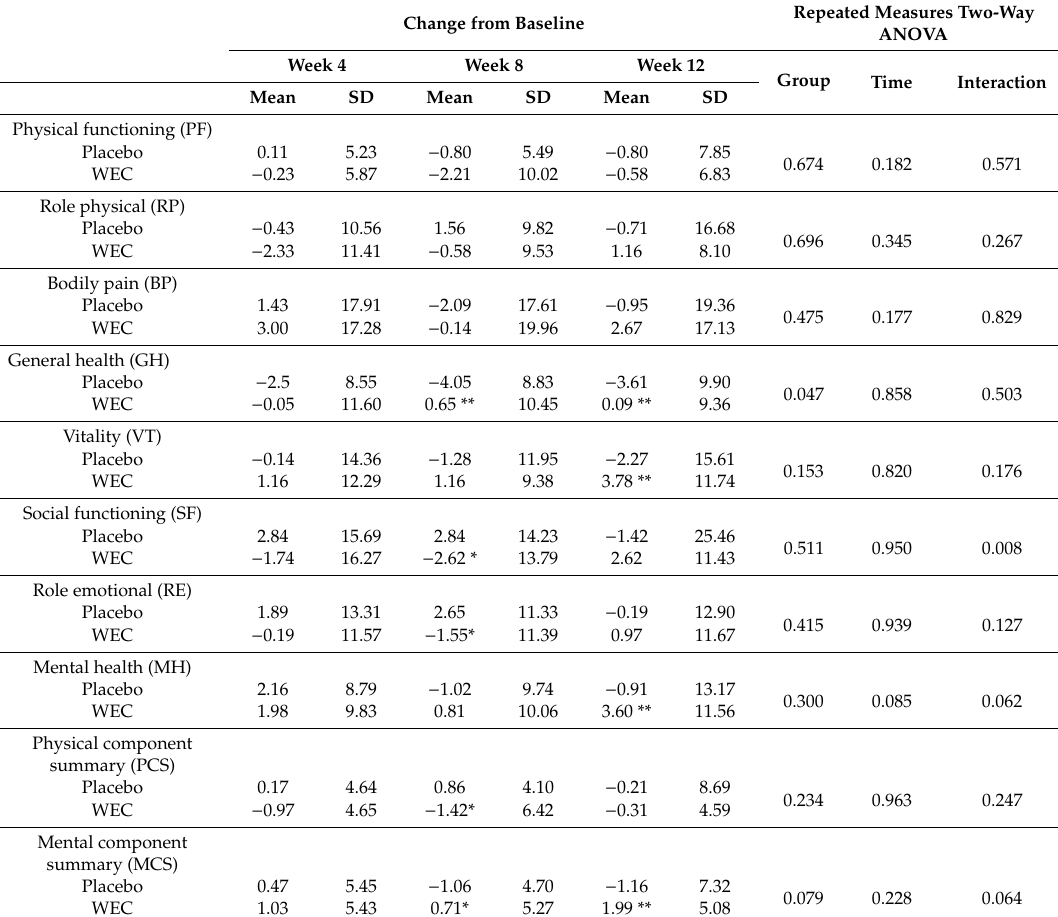
Table 6. E ff ect of a hot water extract of Curcuma longa (WEC) on the MOS 36-item short-form health survey (SF-36) scores 1 .